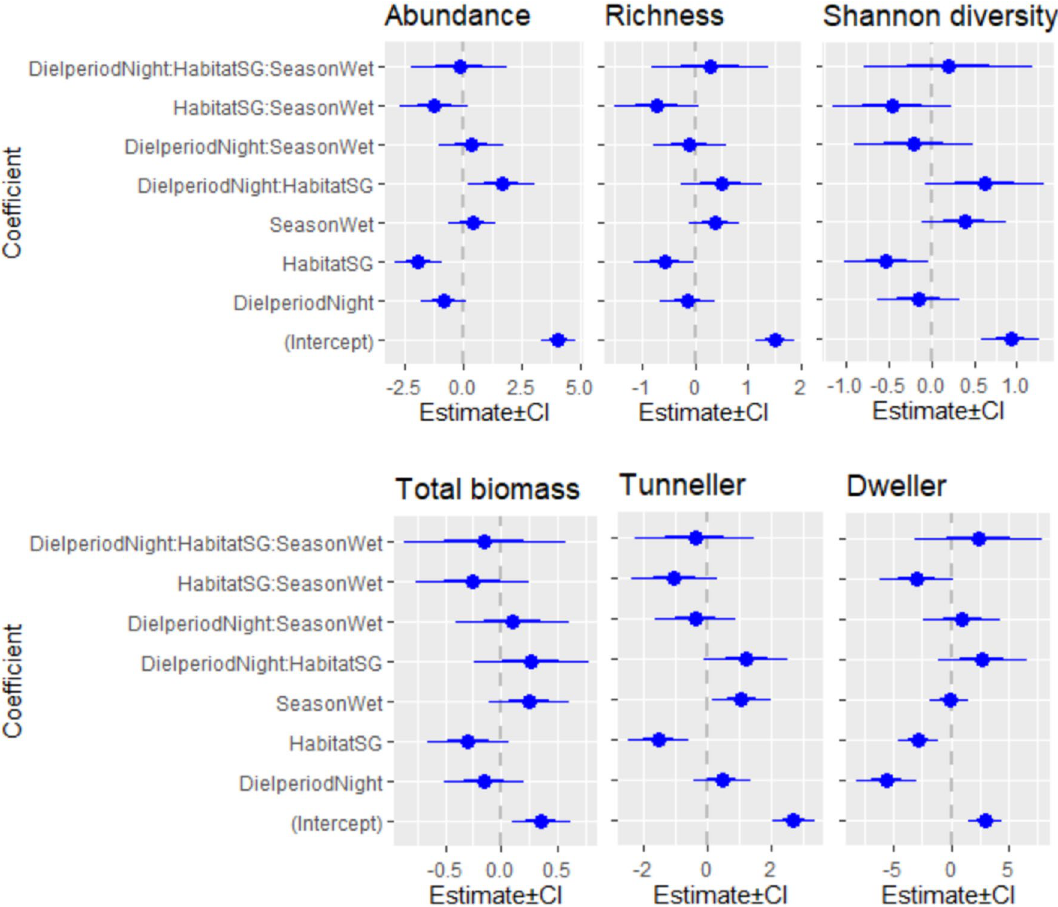
Figure 4. The coefficient plots show the effects of spatiotemporal factors on dung beetle activities, such as abundance, richness, Shannon diversity, total biomass of dung beetles, and abundances of tunneller and dweller beetles. The predictive models have diel period (Day and Night), habitat (HG and SG), season (Dry and Wet), and their interactions as the predictors. In the plots, the estimated value is showed by circle, standard error of the estimate by thick bars, and 95% CI by thin lines. The coefficients that have their SE of the estimate not touching the dashed lines are